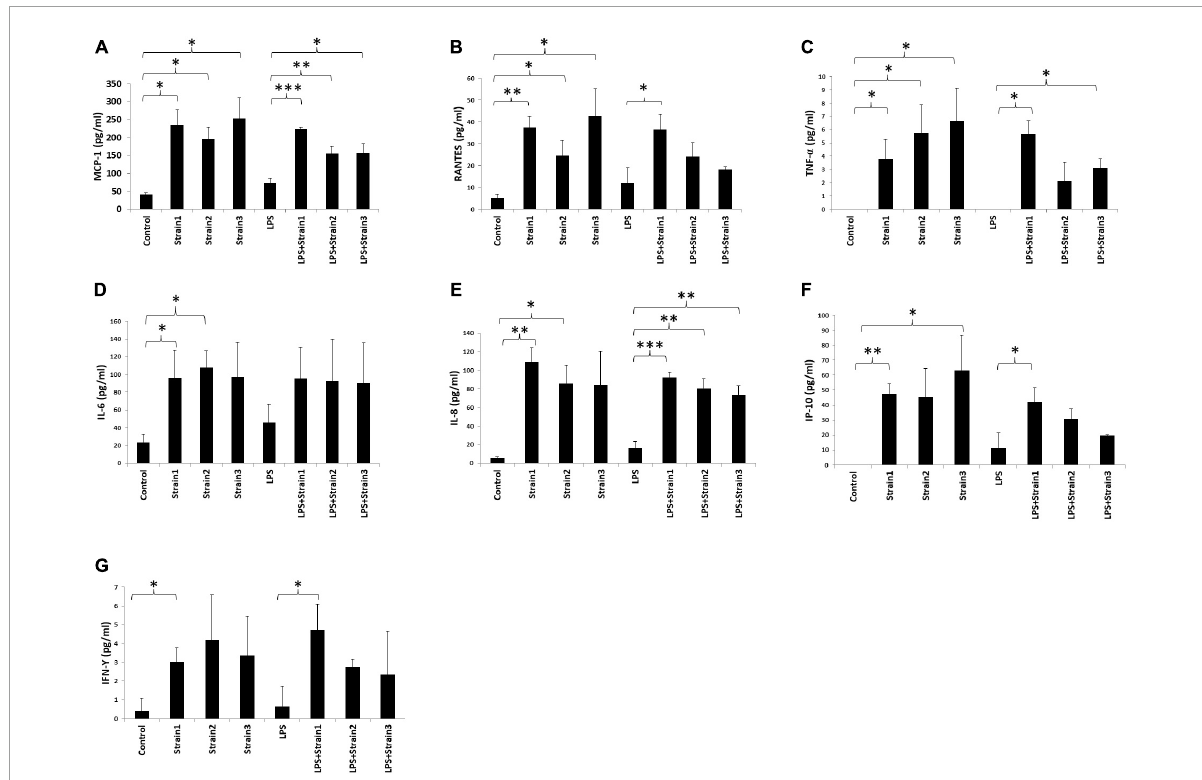
FIGURE7 Achromobacter induced cytokine production in human corneal epithelial cells (cell lysates). (A) MCP-1; (B) RANTES; (C) TNF- upalpha ; (D) IL-6; (E) IL-8; (F) IP-10; (G) IFN- γ . IL, interleukin; TNF, tumor necrosis factor; MIP, macrophage inhibitory protein; MCP, monocyte chemotactic protein; IFN, interferon; IP, interferon gamma-induced protein; RANTES, regulated on activation normal T cell expressed and secreted. The height of bars indicates the mean of three biological replicates. The error bars indicate one standard deviation ∗ p < 0.05, ∗∗ p < 0.01, ∗∗∗ p <